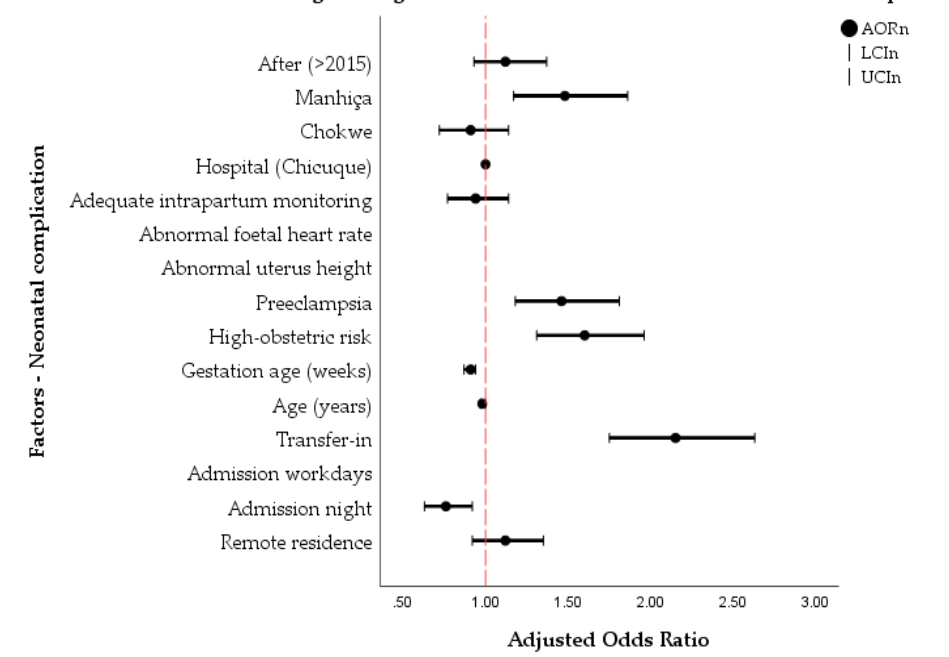
Figure A3. Factors Associated with Neonatal Complications.